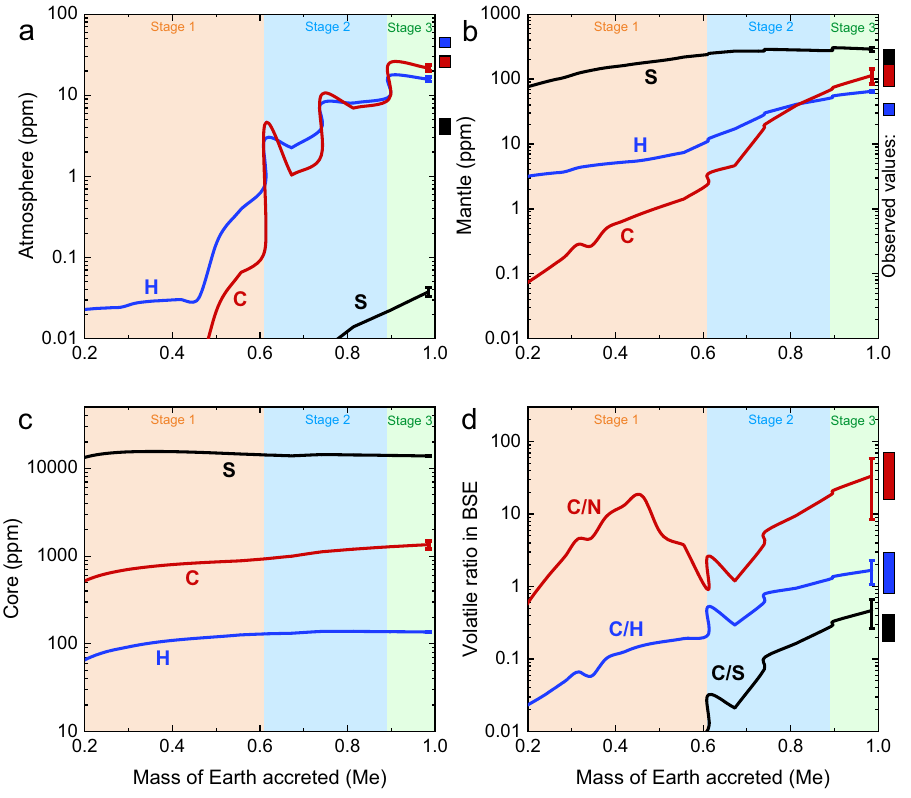
Fig. 5 | Earth ’ s heterogeneous accretion of C – H – S during its main accretion phase.a – c TheC – H – Scontentsinproto-Earth ’ satmosphere,mantle,andcoreasa function of mass fraction accreted. Note that the C – H – S contents in the proto- atmosphere is based on the proto-atmospheric C – H – S-mass normalized to the silicateEarthmass. d TheC/N,C/H,andC/SratiosintheBSE(atmosphere+mantle) change as the mass of Earth accreted. The observed C and H contents in Earth ’ s present-dayreservoirsweretakenfromref.51,andtheScontentinEarth ’ spresent- δ 15 N of the proto-Earth ’ s mantle are ~2.4 ppm and about − 4.7 ‰ , respectively, both of which are consistent with the present-day mantle estimates of ~1 – 3 ppm 5,6,8,51 and − 5±2 ‰ (ref. 22). The N-content of the proto-atmosphereis~1.7 ppm(normalizedtoEarth ’ smantlemass),i.e.,